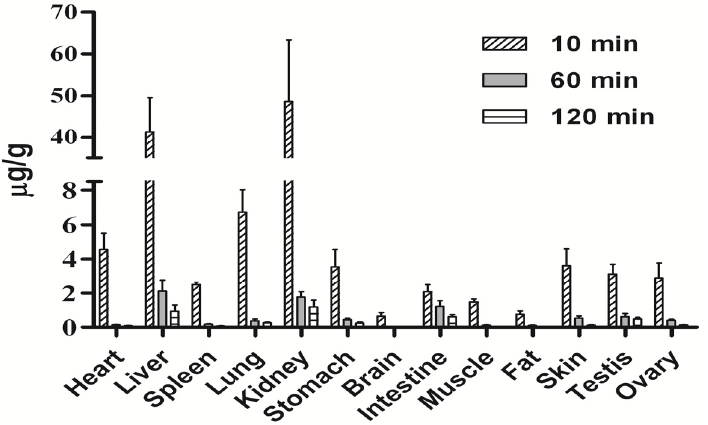
Figure 3. Concentration of wogonin in rat tissues at 10, 60 and 120 min after receiving a single i.v. dose of wogonin at 20 mg/kg. (mean ± SD, n = 6, except for testis/ ovaries where n = 3).